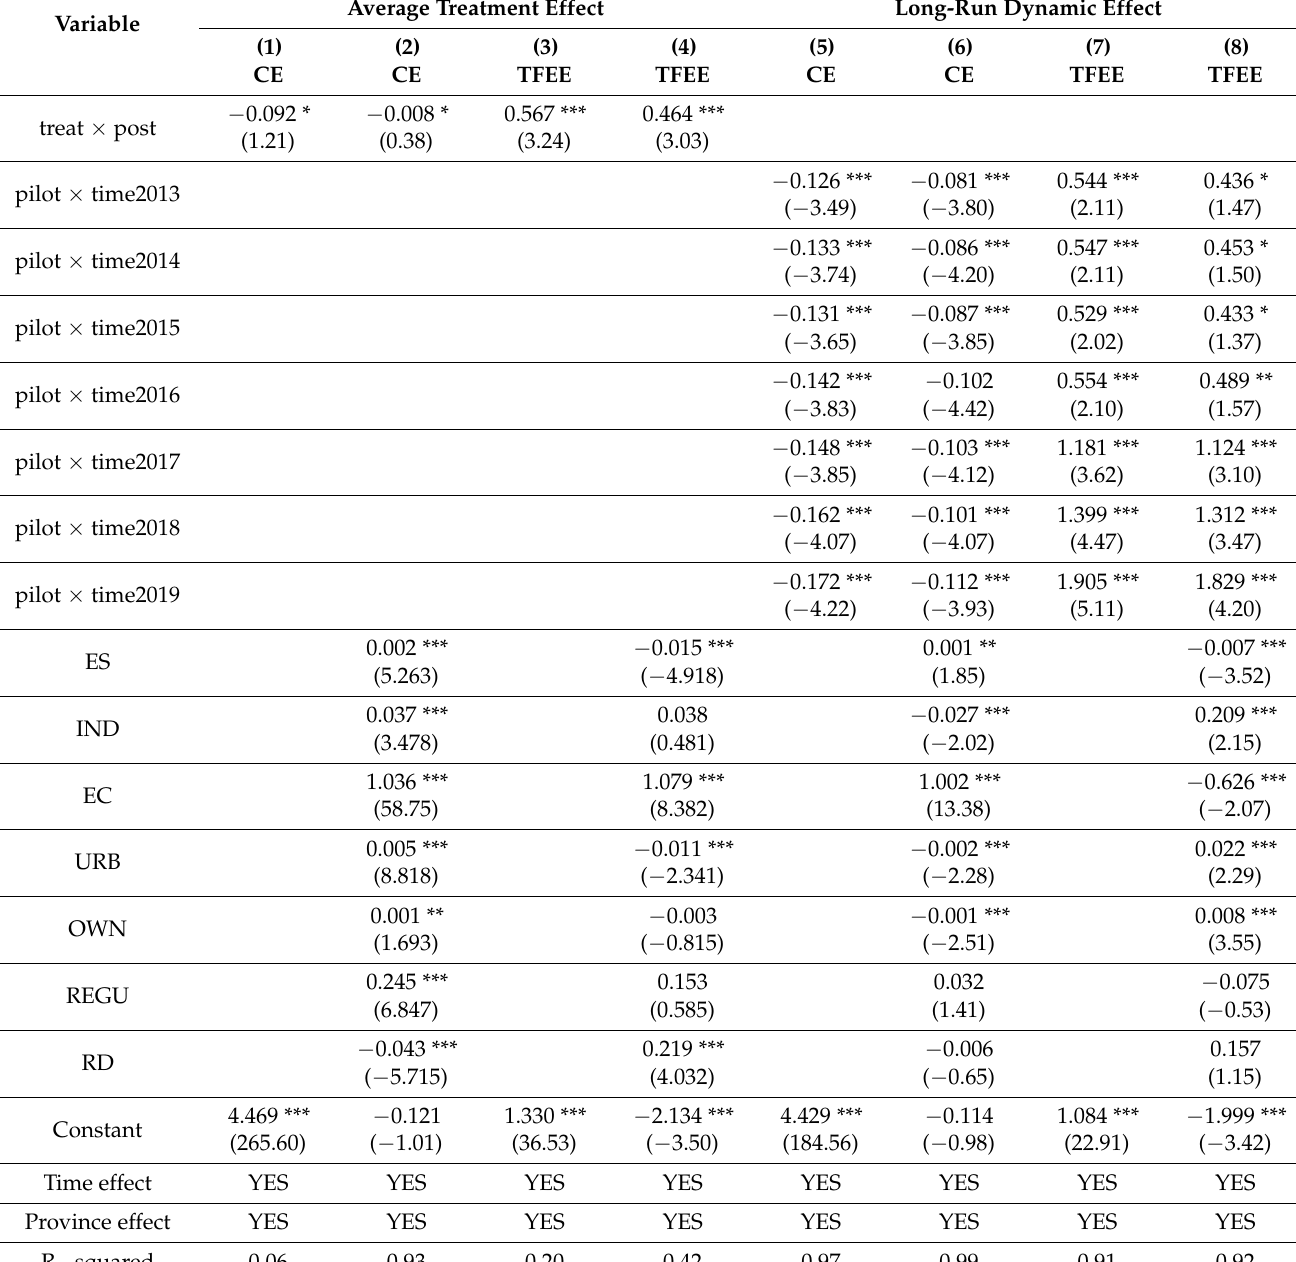
Table 2. Baseline regression